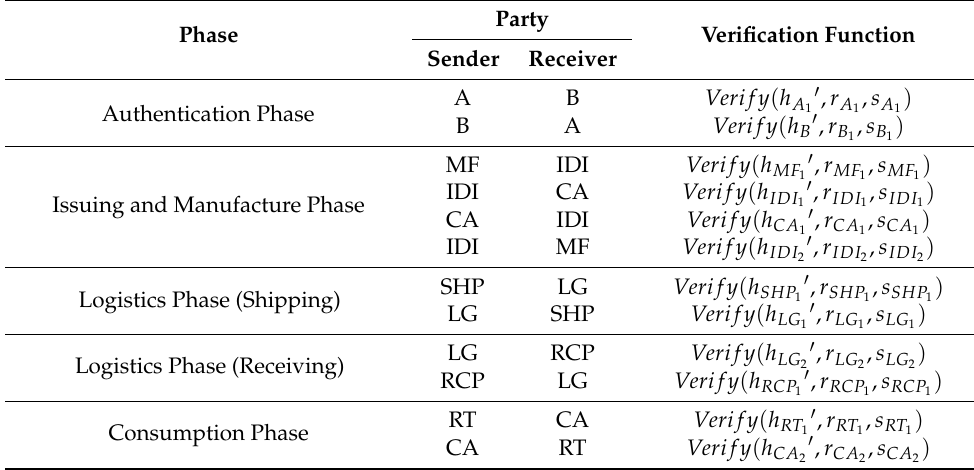
Table 2. Non-repudiation’s verification of the proposed